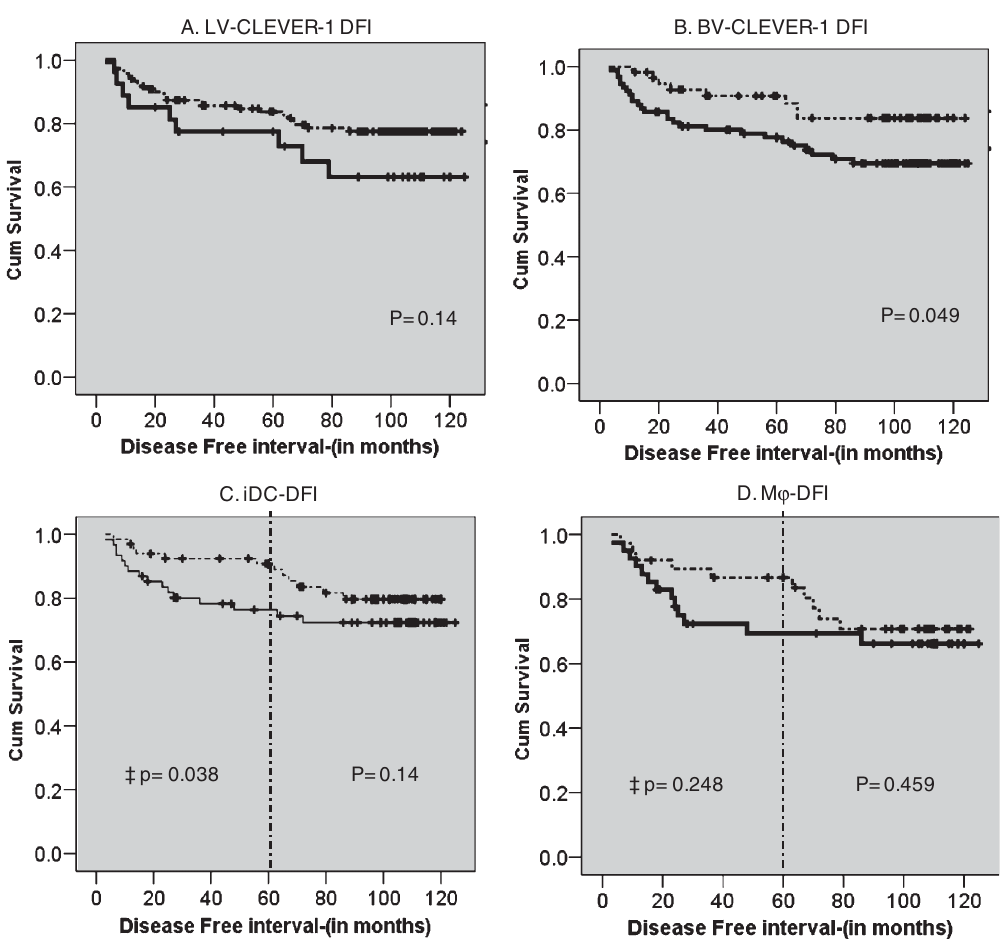
Fig. 3. Kaplan-Meier survival curves of DFI versus CLEVER-1 expression in BV and LV, and versus iDC and M (cid:1) indices. There was no statistical significance of CLEVER-1 expression in LV and recurrence rates over 120 months ( p =0.14) however BV-CLEVER-1 expression may predict regional recurrence in breast cancer patients ( p =0.049). Dashed line represents a 60 month follow-up cut-off period. iDC index is predictive of decreased DFI at 60 months follow-up ( p =0.038) but not at later times. ‡ Represents the p value of iDC and M (cid:1) at 60 months. p <0.05 represents statistical